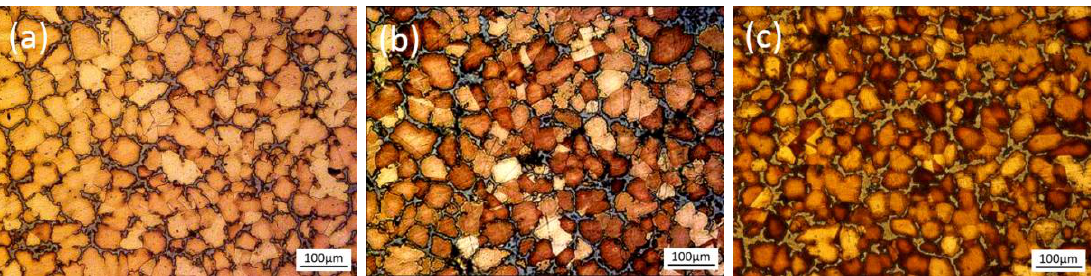
Figure 7. Microstructures of ZCuSn10P1 alloy at different pouring lengths at a pouring temperature of 1080 °C: ( a ) 200 mm; ( b ) 300 mm; and ( c ) 400 mm.